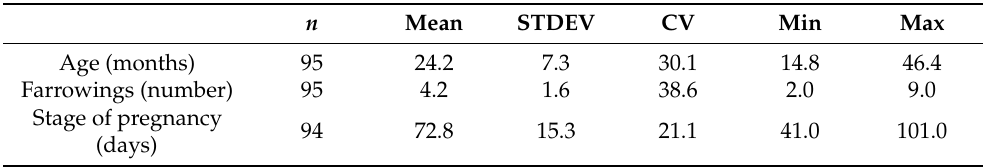
Table 1. Age, number of farrowings, and stage of pregnancy of the sows according to the farmer’s documentation (with STDEV = Standard Deviation, CV = coefficient of variation, Min = minimal value, Max = maximal value).